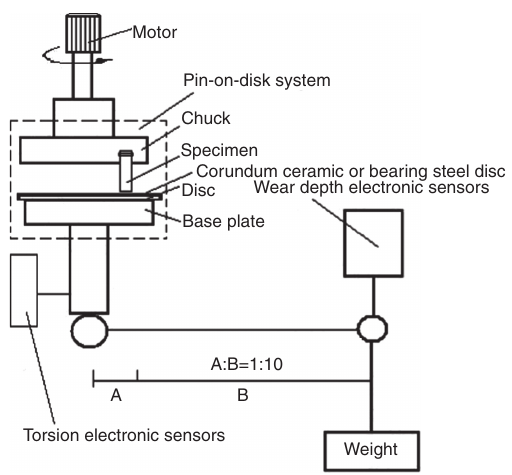
Figure 1 Schematic experimental setup for carrying out the wear tests.